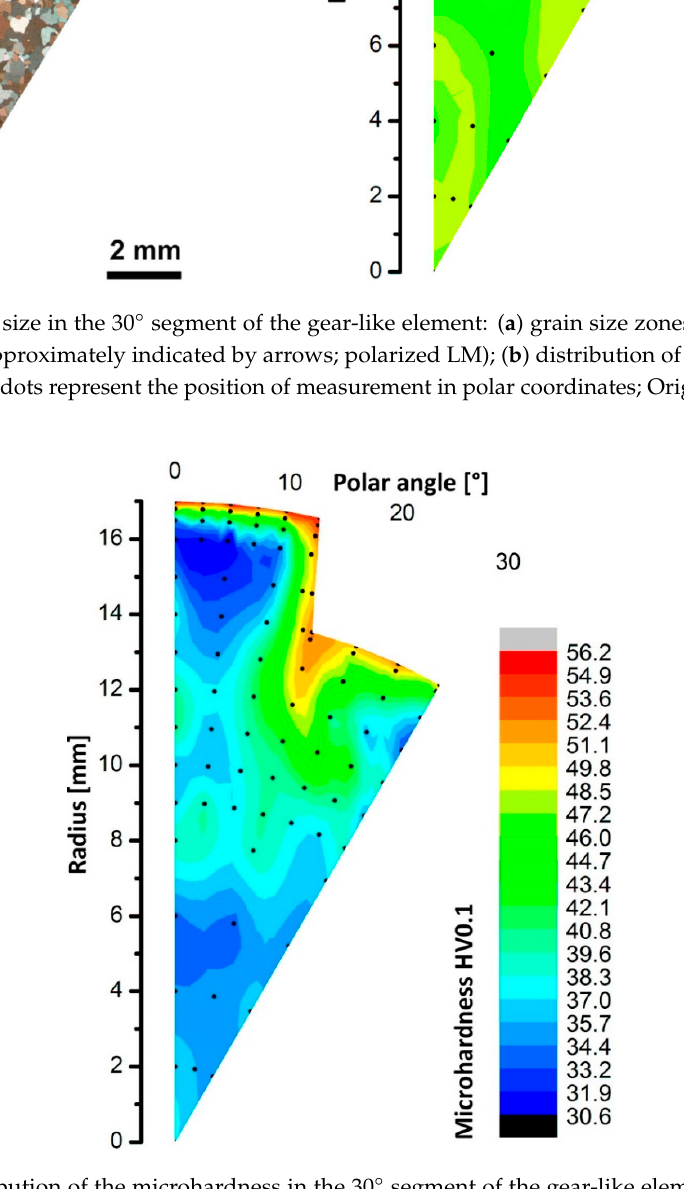
Figure 9. Distribution of the microhardness in the 30 ◦ segment of the gear-like element (black dots represent the position of measurement in polar coordinates; OriginPro8.6, Polar Contour Plot).